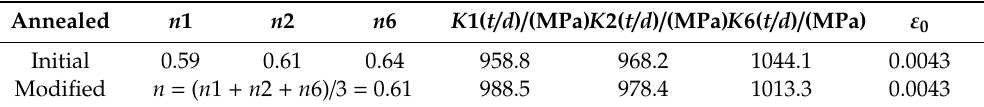
Table 2. The initial and modified values for n and K ( t / d ).